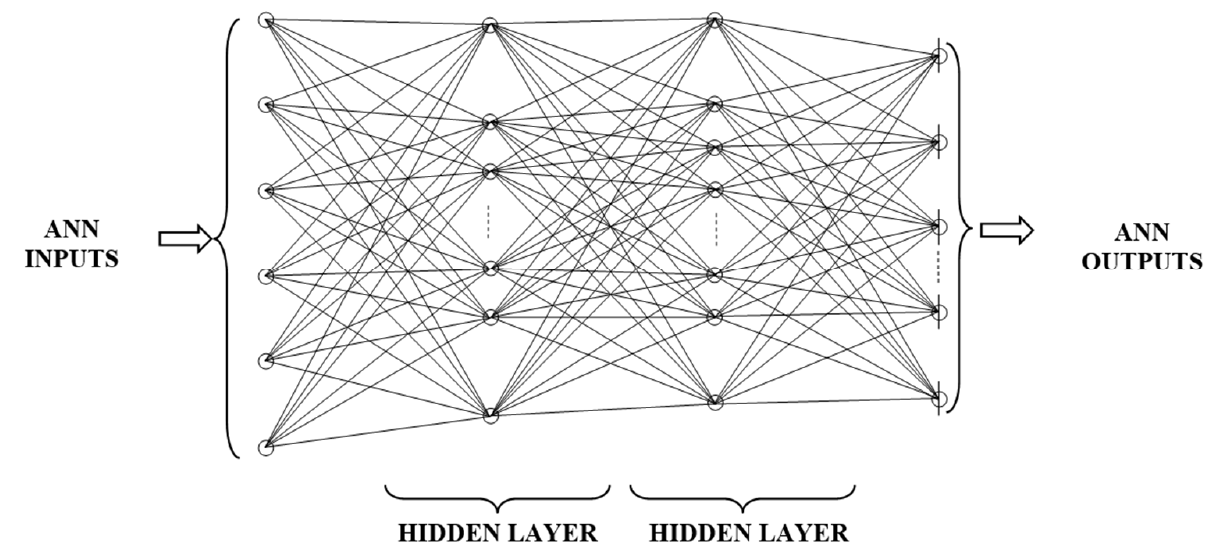
Figure 2. Typical structure of a multilayer ANN.